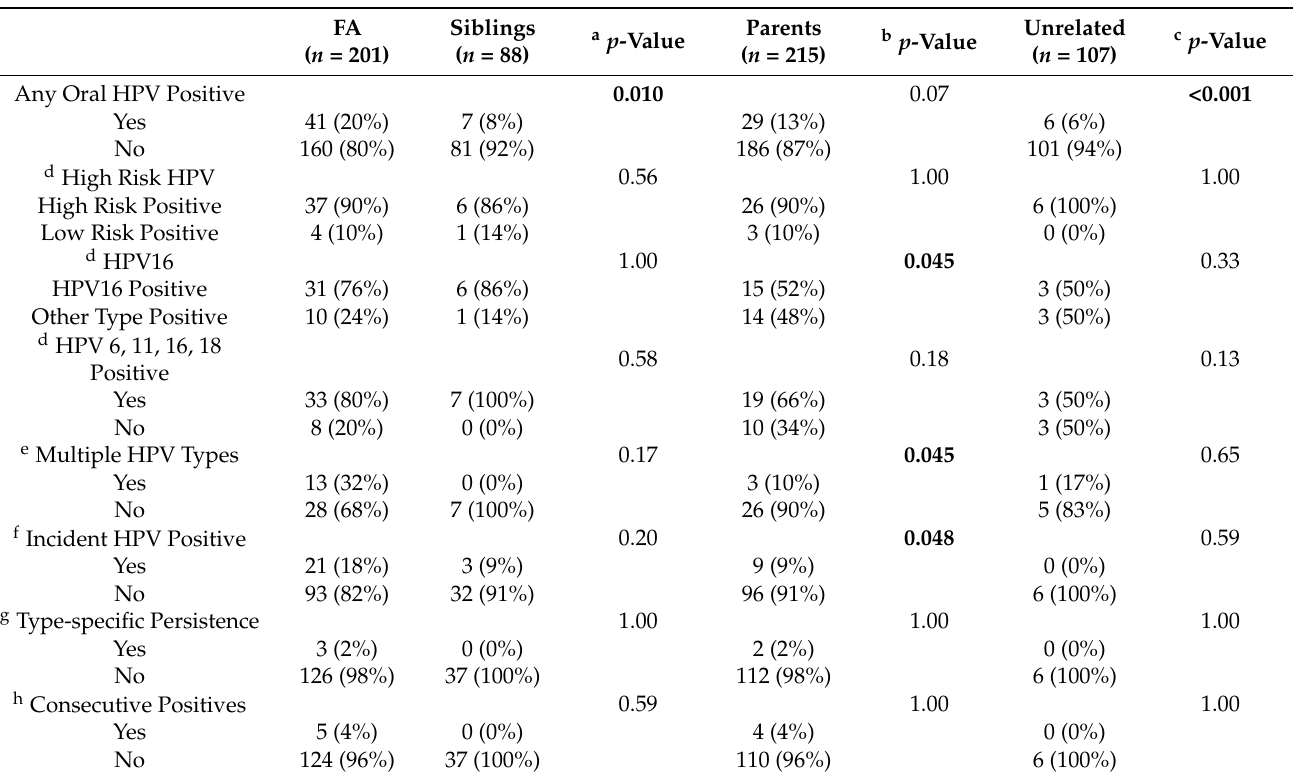
Table 2. Oral HPV DNA